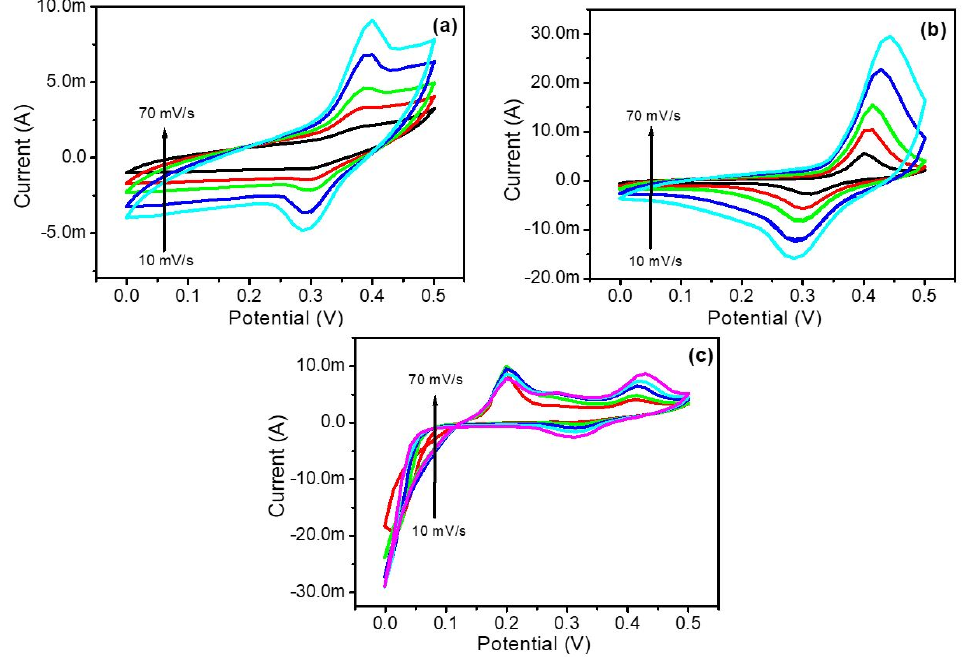
Figure 8. CV curve of ( a ) pure MnO 2 rods, ( b ) rGO@MnO 2, and ( c ) Ag-rGO@MnO 2 at various scan rates.